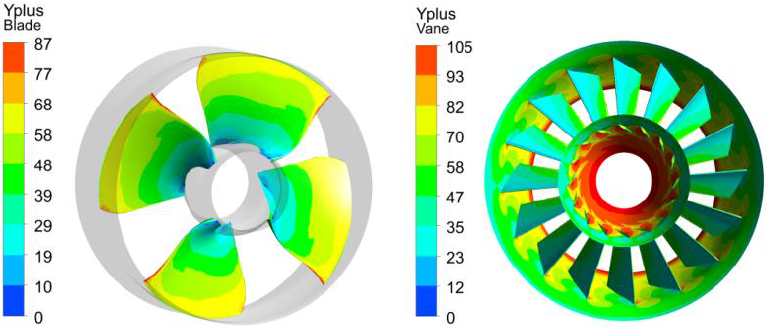
Figure 5. y+ distribution on blade and guide vane surface.